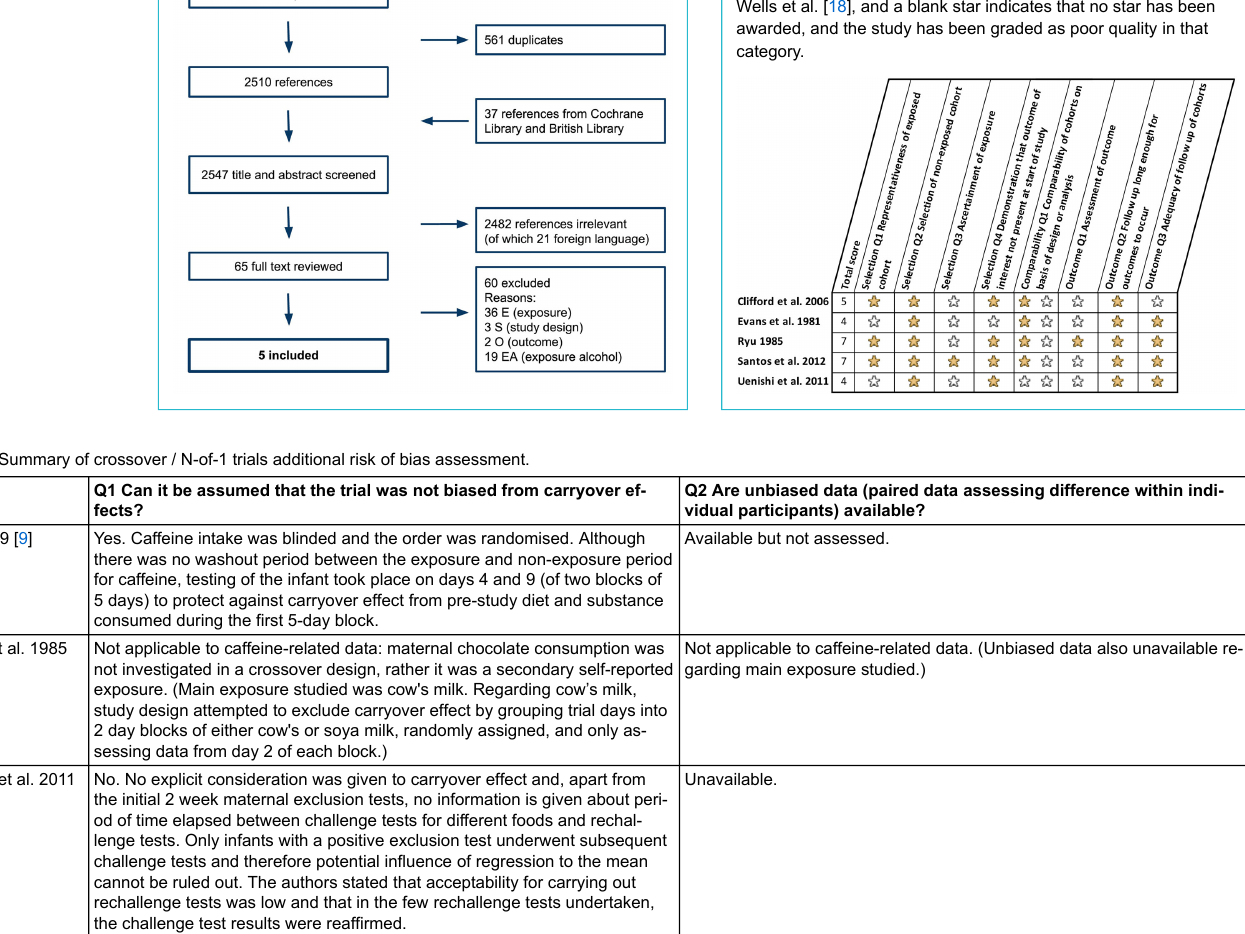
Figure 3: Summary of risk of bias assessment based on Newcas- tle-Ottawa Quality Assessment Scale for Cohort Studies. A filled yellow star indicates that a star has been awarded, as outlined by Wells et al. [18], and a blank star indicates that no star has been awarded, and the study has been graded as poor quality in that category.